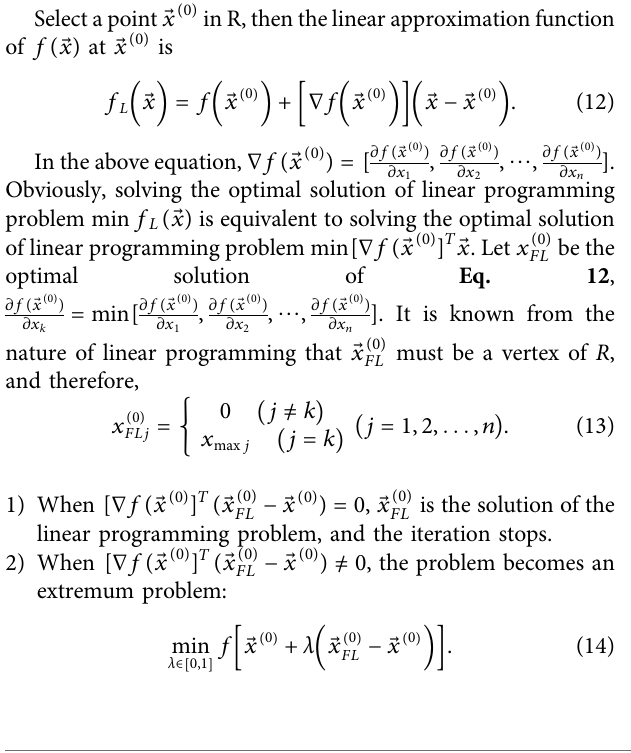
Frontiers in Energy Research |